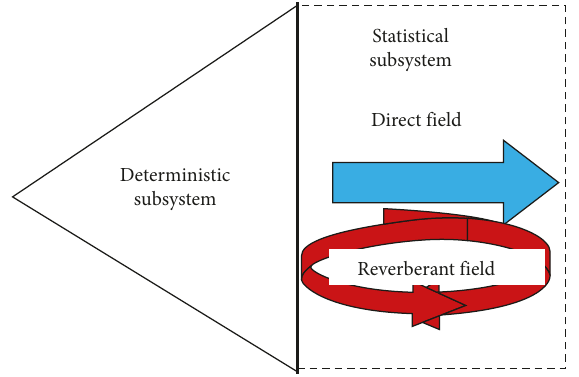
Figure 11: Direct-hybrid field reciprocal relationship.